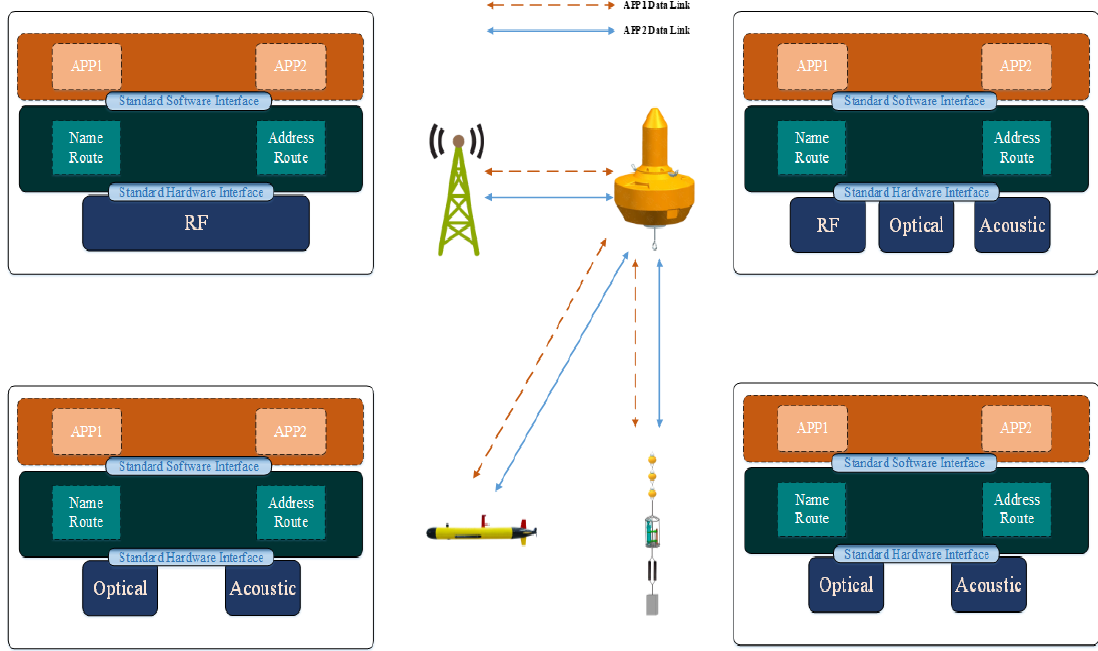
Figure 13. Status and information of each network node.